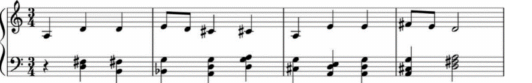
Figure 1. Music notation representing the analyzed fragment of an exemplary piece of